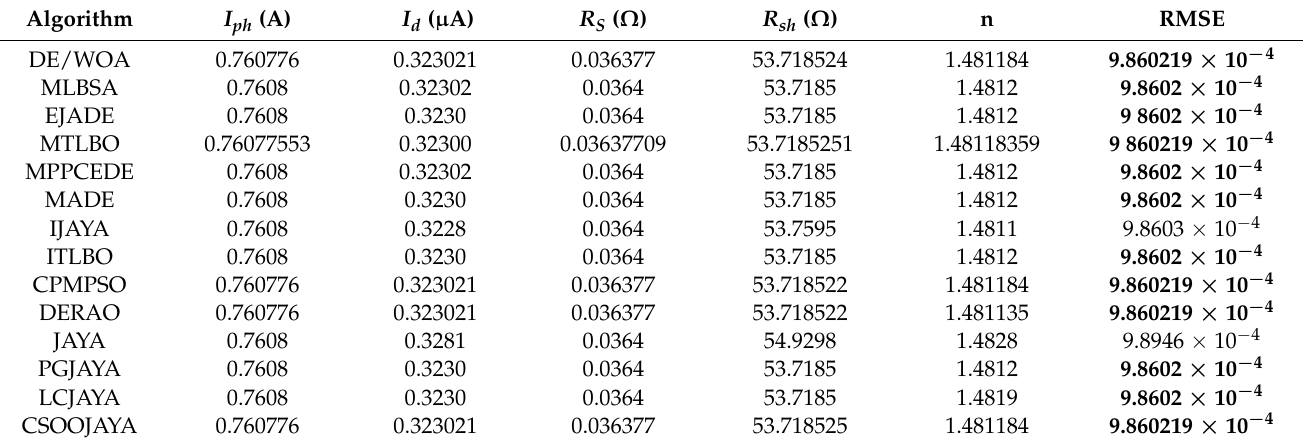
Table 5. Comparison of the extracted optimal parameters of the